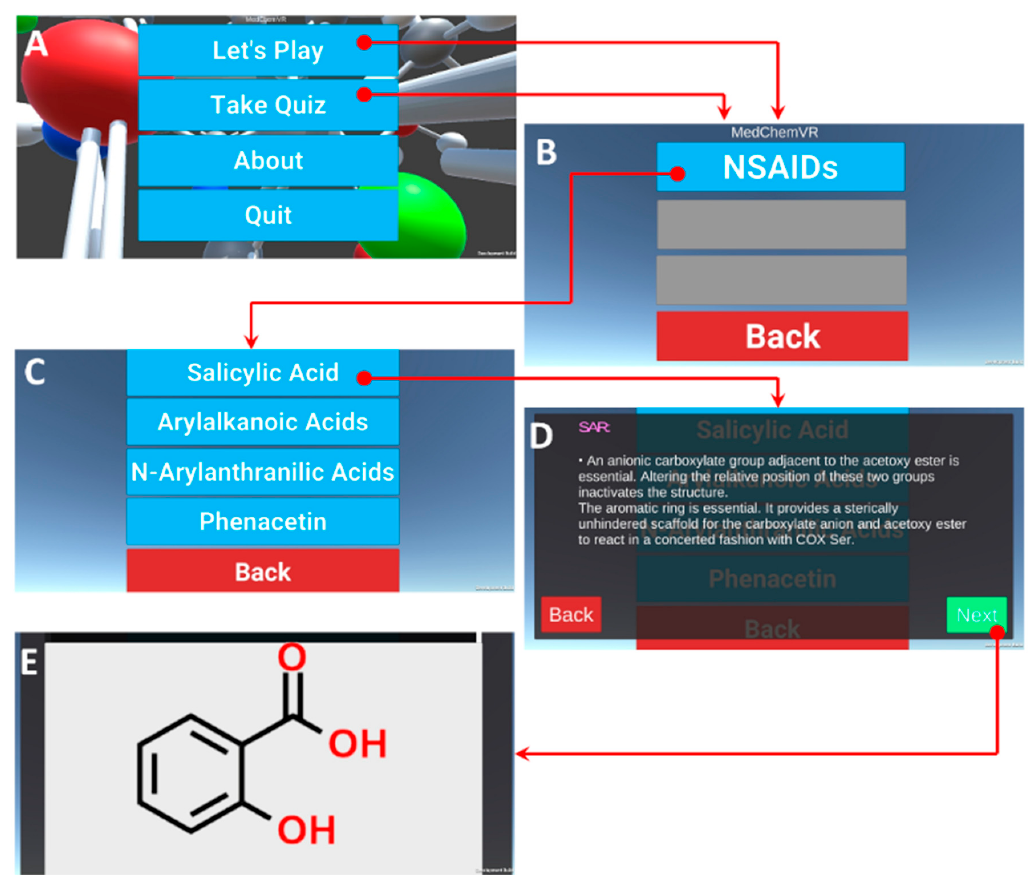
Figure 2. The consecutive interfaces of the MedChemVR. ( A ) The start screen. ( B ) The second interface in either the “Let’s Play/Take a Quiz” mode takes the student to the next interface. ( C ) The chemical sub-classes to which drugs belong. ( D ) The structure-activity relationships (SAR) of each subclass. ( E ) Visualization of the two-dimensional (2D) structure of each drug, by clicking on the 2D structure, the student will be guided to the VR classroom.